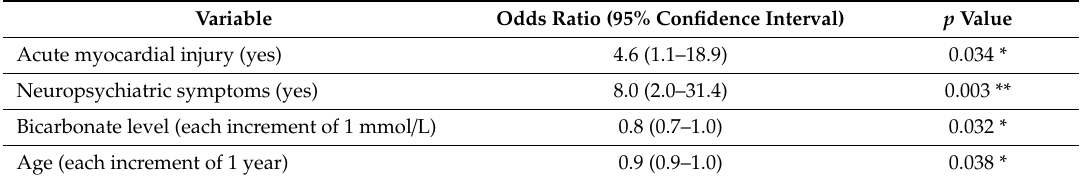
Table 3. Multivariable logistic regression analysis of predictors for globus pallidus necrosis ( n = 67). Variable Odds Ratio (95% Confidence